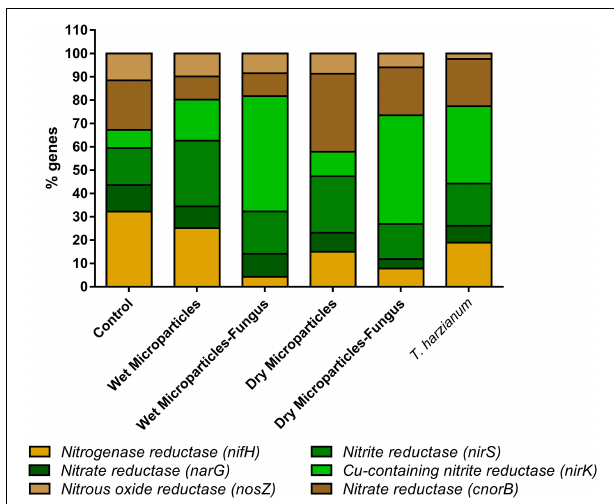
FIGURE 2 | Molecular evaluation of the soil microbiota, in terms of the proportions of genes obtained using real-time PCR, after 30 days of treatment. The results showed that there was a decrease of the nitrogen-fixing bacteria and increase of the denitrifiers, compared to the negative control, while there was no change in the soil microbiota, comparing the encapsulated and unencapsulated T.